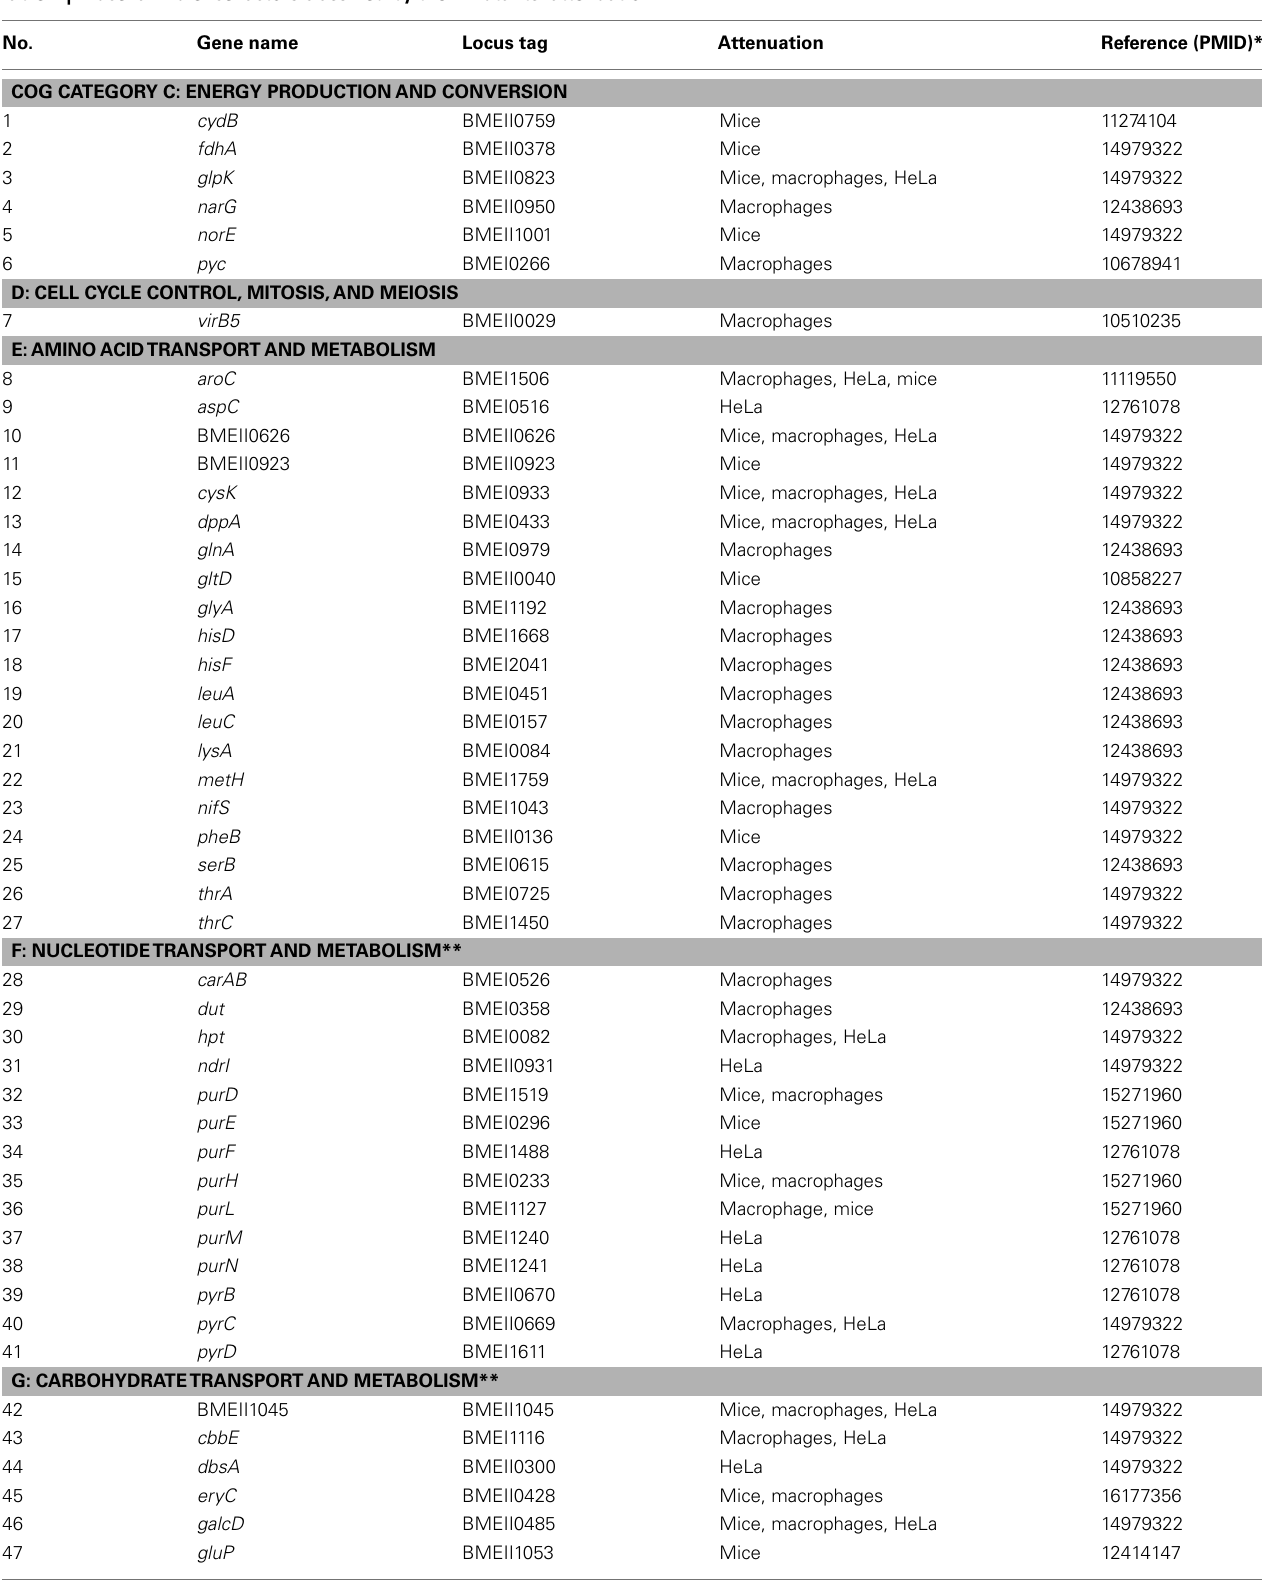
Table 2 | Brucella virulence factors classified by their mutants’